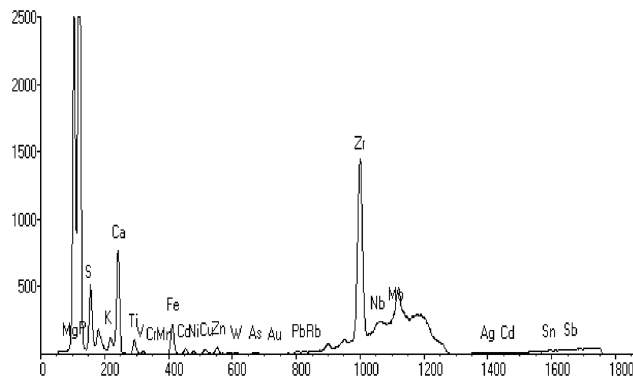
Fig. 3. XRF peaks for PU foam with kaolin.